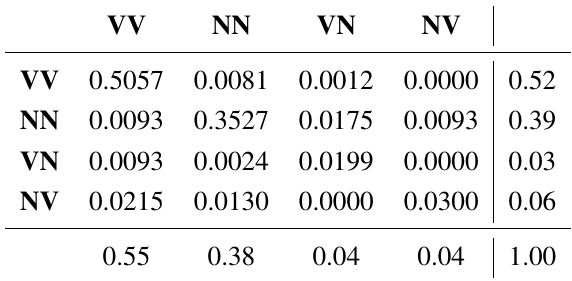
Table 4. Confusion matrix for the change detection between 2003 and 2013 classifications. “V” stands for “Vegetated” surfaces, whilst “N” for “Non vegetated”, so, for example, “NV” means a change from Non-vegetated in 2003 to Vegetated in